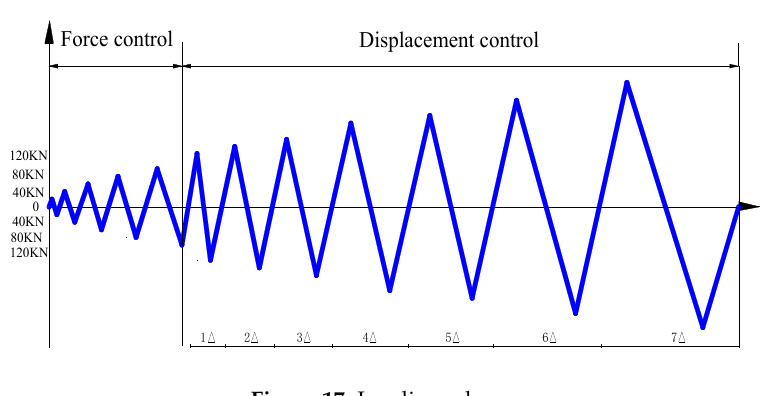
Figure 17. Loading scheme.